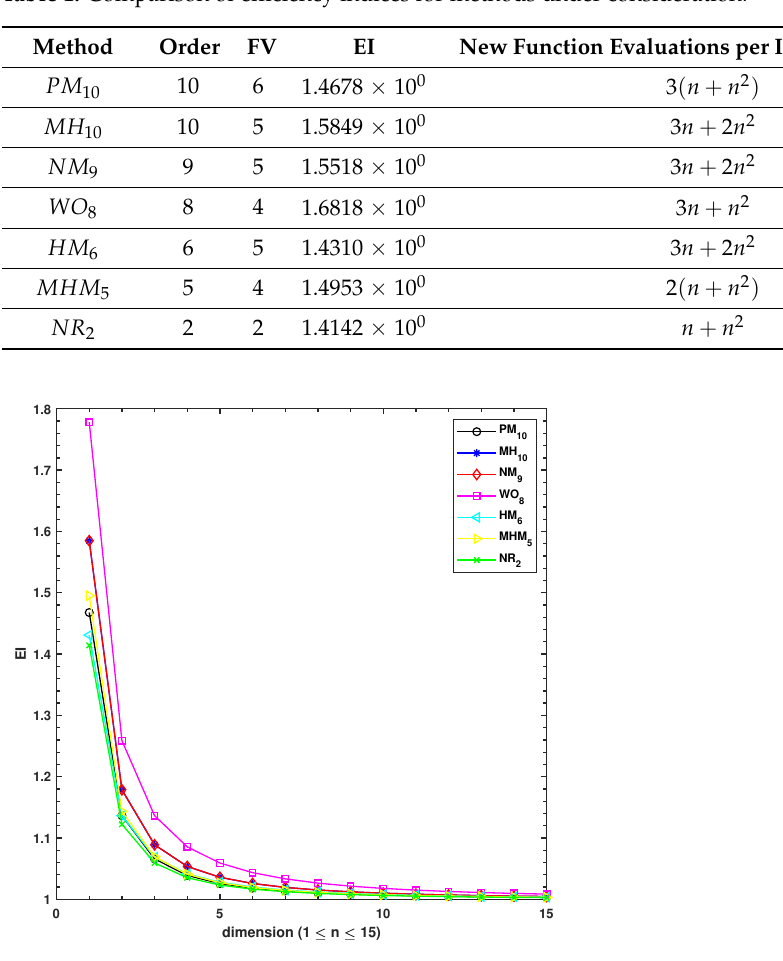
Table 1. Comparison of efficiency indices for methods under consideration.